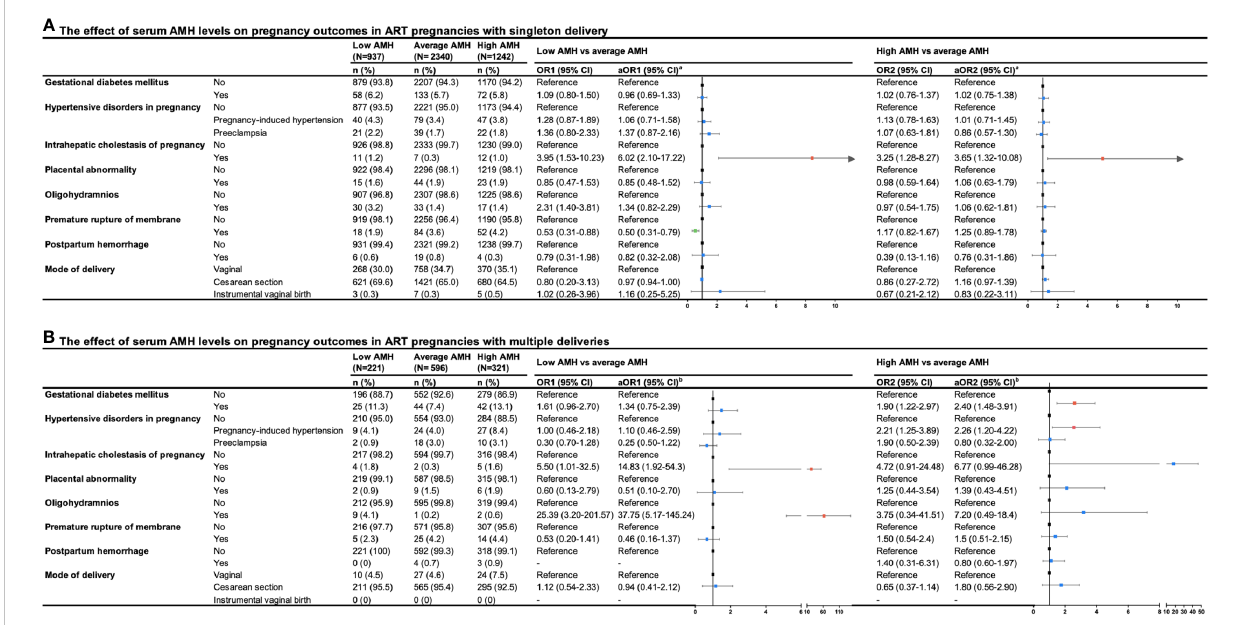
FIGURE 2 Forest plot summary of logistic regression analysis for risks of pregnancy outcomes in ART pregnancies with (A) singleton and (B) multiple deliveries. OR, odd ration; CI, con fi dence interval; aOR, adjusted odds ratio. aaOR was adjusted maternal age, paternal age, race, residence, gravidity, parity, duration of infertility, primary infertility, causes of infertility, study center, controlled ovarian stimulation protocol, type of insemination, transfer cycle types, embryo types, number of embryos transferred. baOR was adjusted maternal age, paternal age, residence, gravidity, parity, primary infertility, causes of infertility, study center, controlled ovarian stimulation protocol, type of insemination, transfer cycle types, embryo